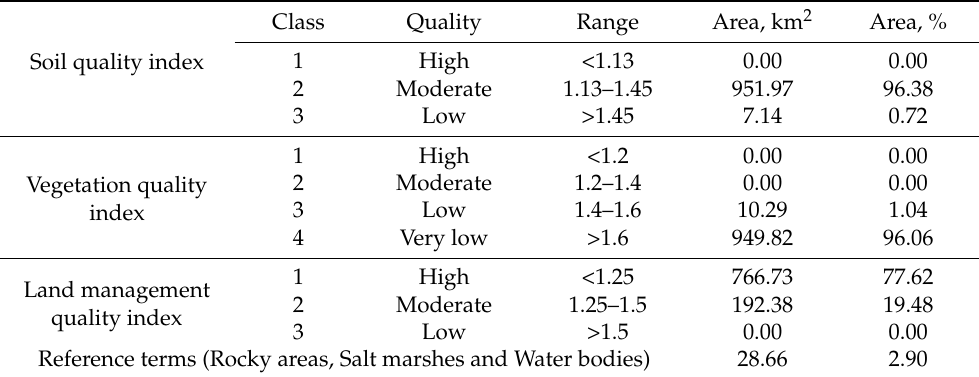
Table 4. Classes and areas of quality indices of the modified MEDLAUS